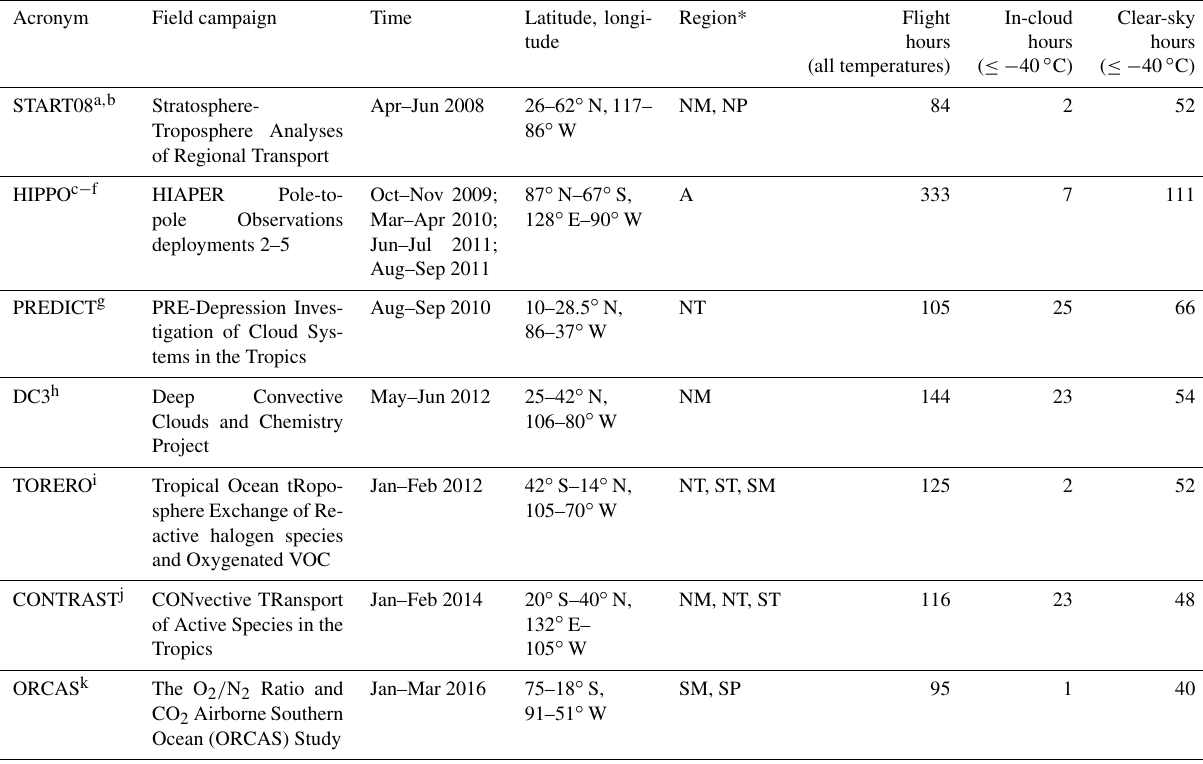
Table 1. Descriptions of seven NSF flight campaigns conducted with the NSF/NCAR GV research aircraft.